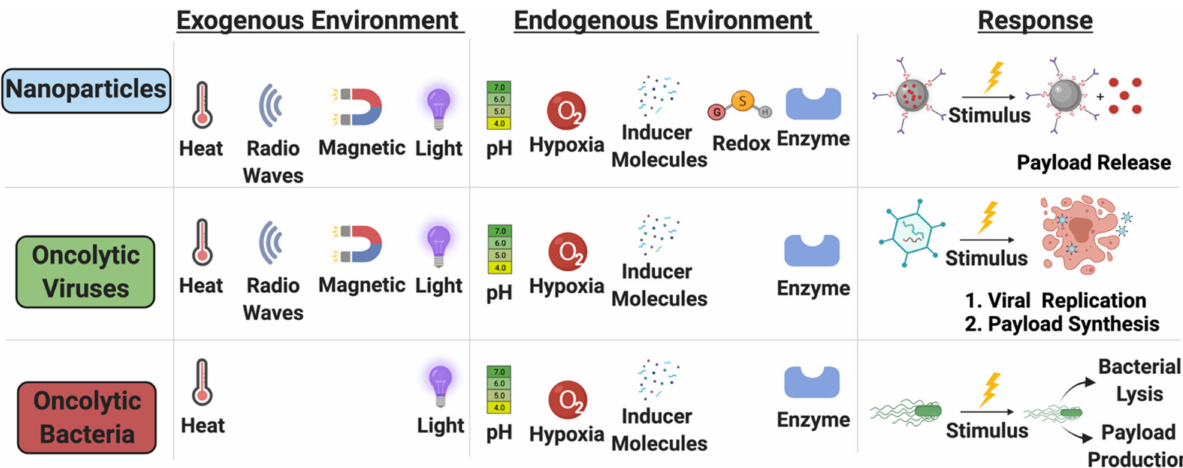
Figure 5. Mechanisms to enhance drug delivery. Examples of the exogenous and endogenous stimuli resulting in various drug or payload release. References—NP: [234,235,248], OV: [261,262]. OB